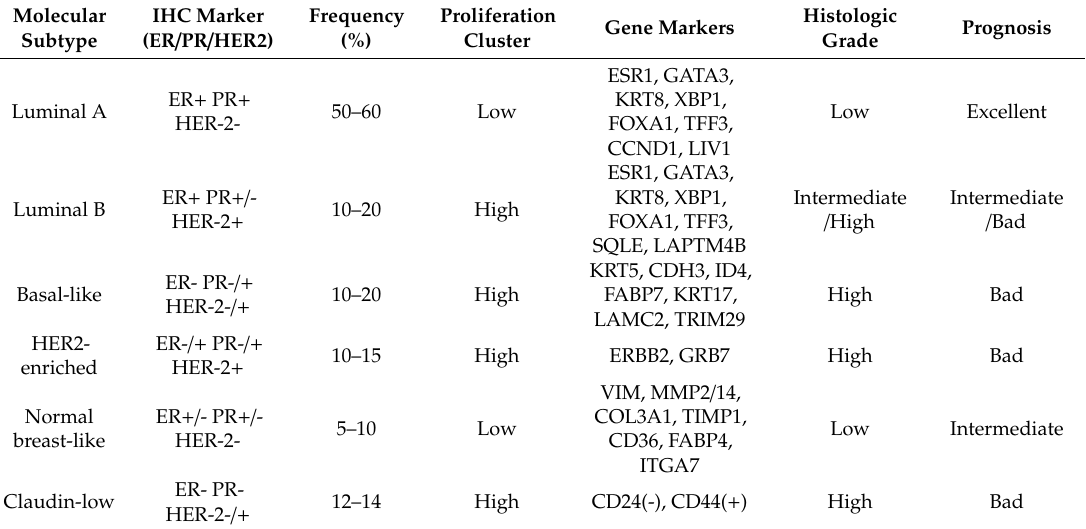
Table 1. Feature of breast cancer subtypes (modified from